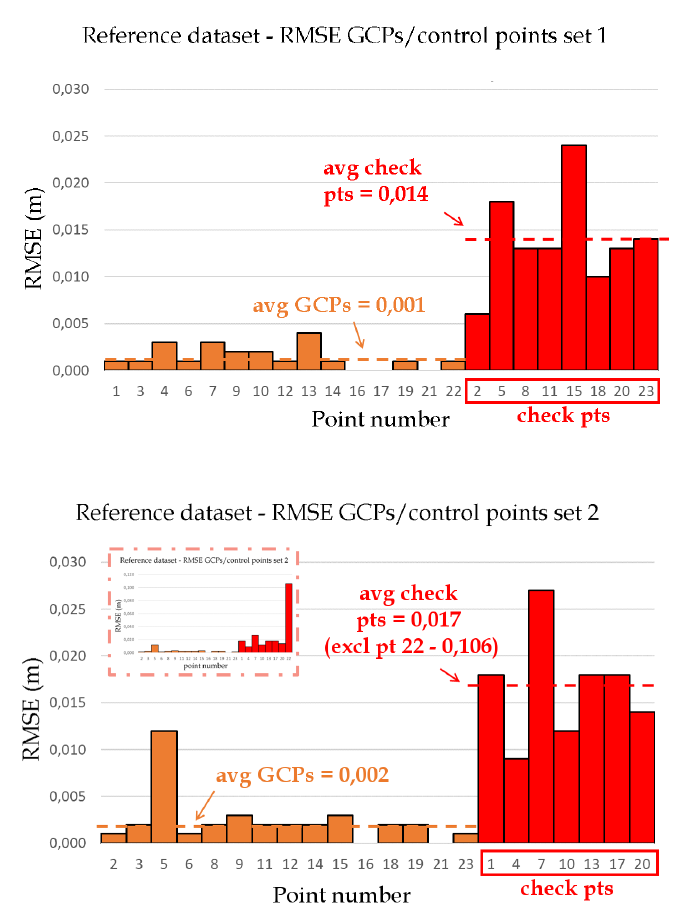
Figure 7. Reference module—RMSE of the ground control points and check points with two different random subsets of points as ground